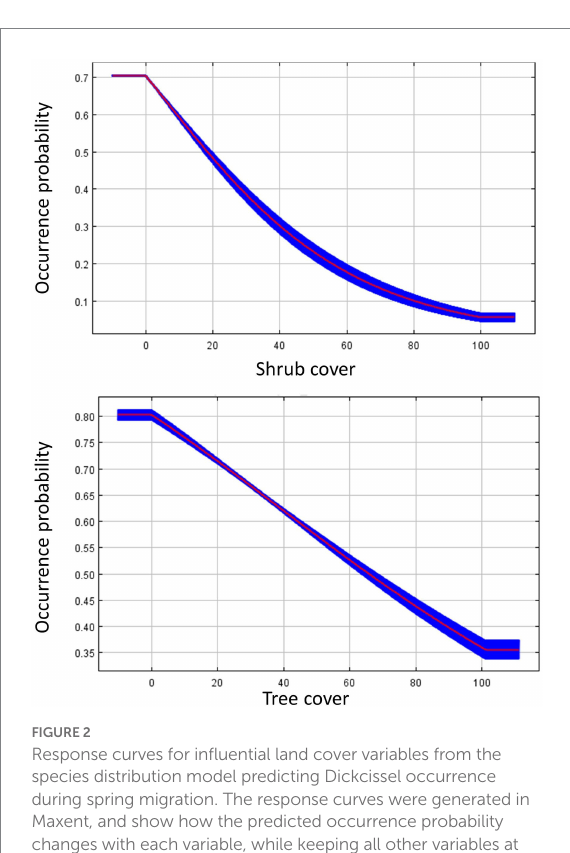
FIGURE 2 Response curves for influential land cover variables from the species distribution model predicting Dickcissel occurrence during spring migration. The response curves were generated in Maxent, and show how the predicted occurrence probability changes with each variable, while keeping all other variables at their average sample value. The red line plots the average value of the five model replicates, and the blue area plots the variance among the five replicates.